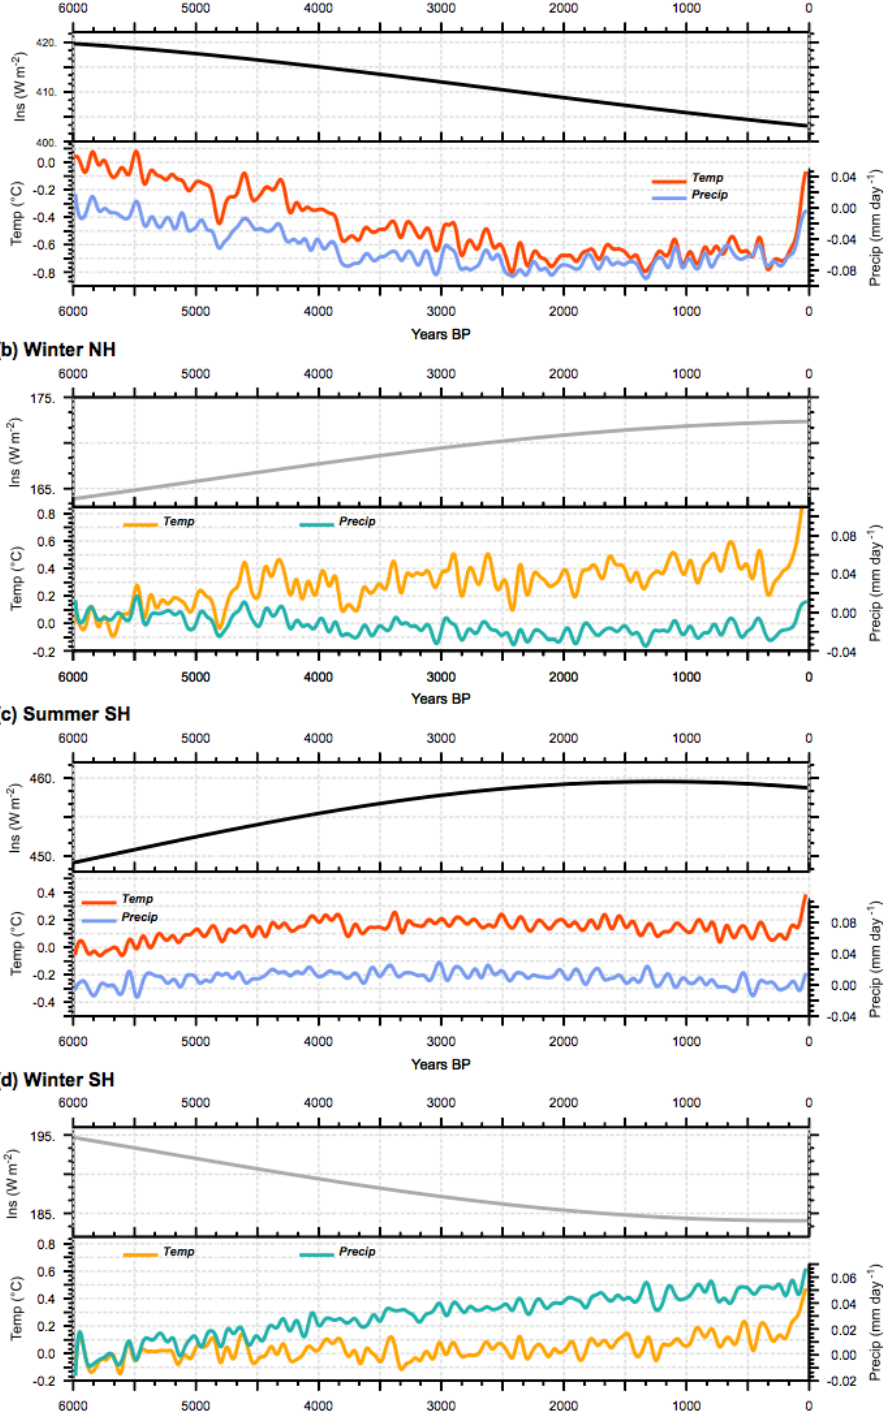
Figure 6. Long-term evolution of incoming solar radiation at the top of the atmosphere (TOA) (Wm − 2 ; upper section of panels) and associated response of temperature ( ◦ C) and precipitation (mmyr − 1 ) expressed as the difference to the 6000BP initial state and smoothed by a 100-year running mean) for (a) NH summer, (b) NH winter, (c) SH summer, and (d) SH winter. Temperatures are plotted in red and precipitation in blue for summer, and they are, respectively, plotted in orange and green for winter. NH summer and SH winter correspond to June to September averages, whereas NH winter and SH summer correspond to December to March averages. All curves, except insolation, have been smoothed by a 100-year running